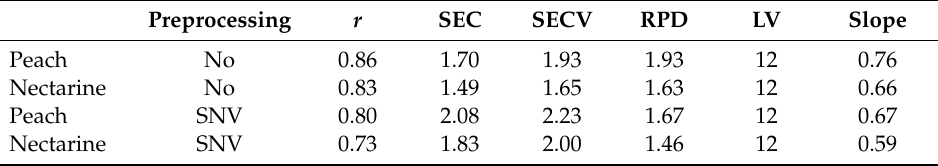
Table 4. Coe ffi cient of correlation ( r ), standard error of calibration (SEC), standard error of cross-validation (SECV), ratio of the prediction to deviation (RPD), number of latent variables (LV), and slope of the near-infrared (NIR) models to estimate instrumental juiciness (Ajuice, cm 2